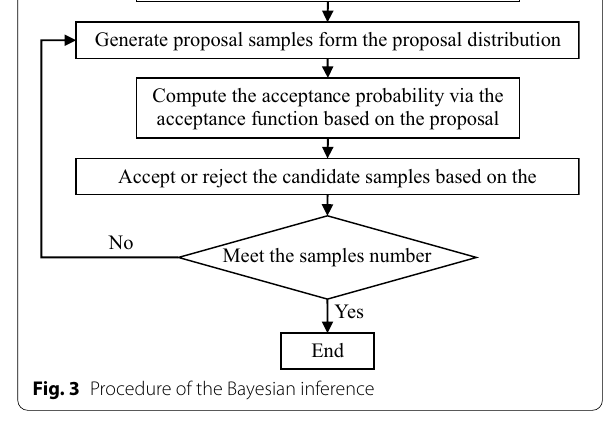
Fig. 3 Procedure of the Bayesian